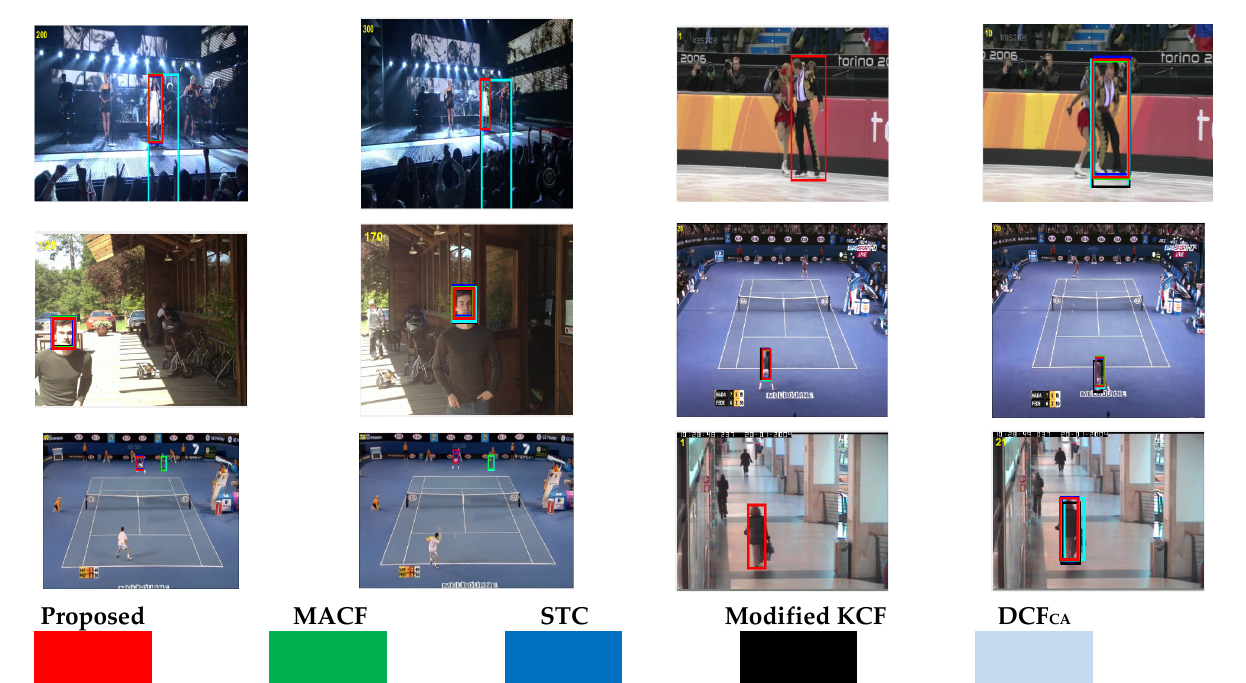
Figure 5. Qualitative comparison on TC-128, OTB2013, OTB2015, and UAV123 datasets.